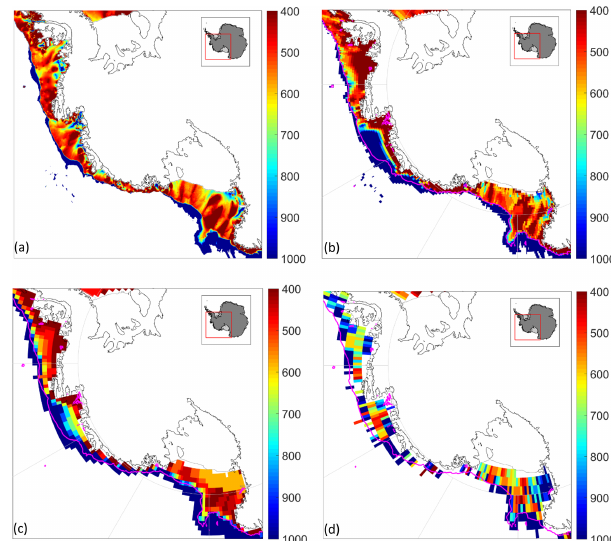
Figure 10. Bathymetry between 400 and 1000m of (a) IBCSO (500m horizontal resolution), (b) WOA (0.25 ◦ horizontal resolu- tion), (c) CESM2 (1 × 0 . 5 ◦ long/lat resolution) and (d) the WOD bin-averaged into 1 ◦ horizontal resolution with all types of instru- ment with temperature measurements. The magenta line indicates the 1000m IBCSO depth